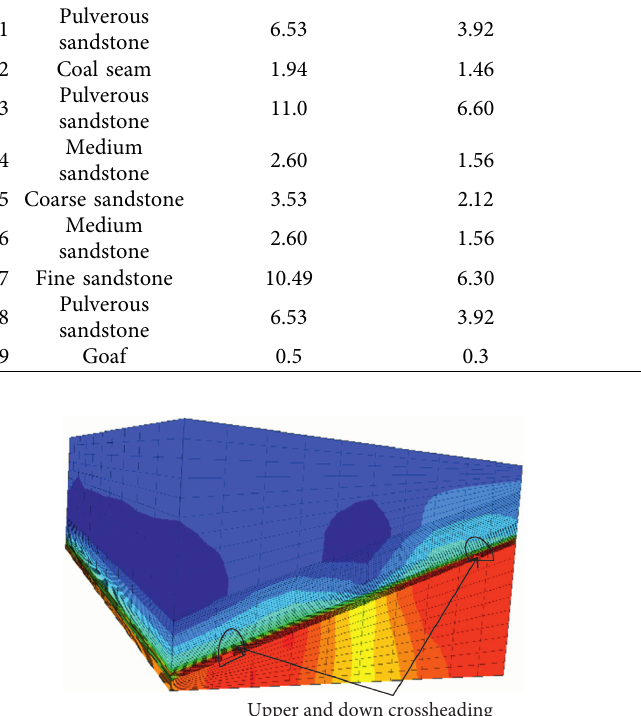
Figure 5: Model vertical stress cloud diagram.